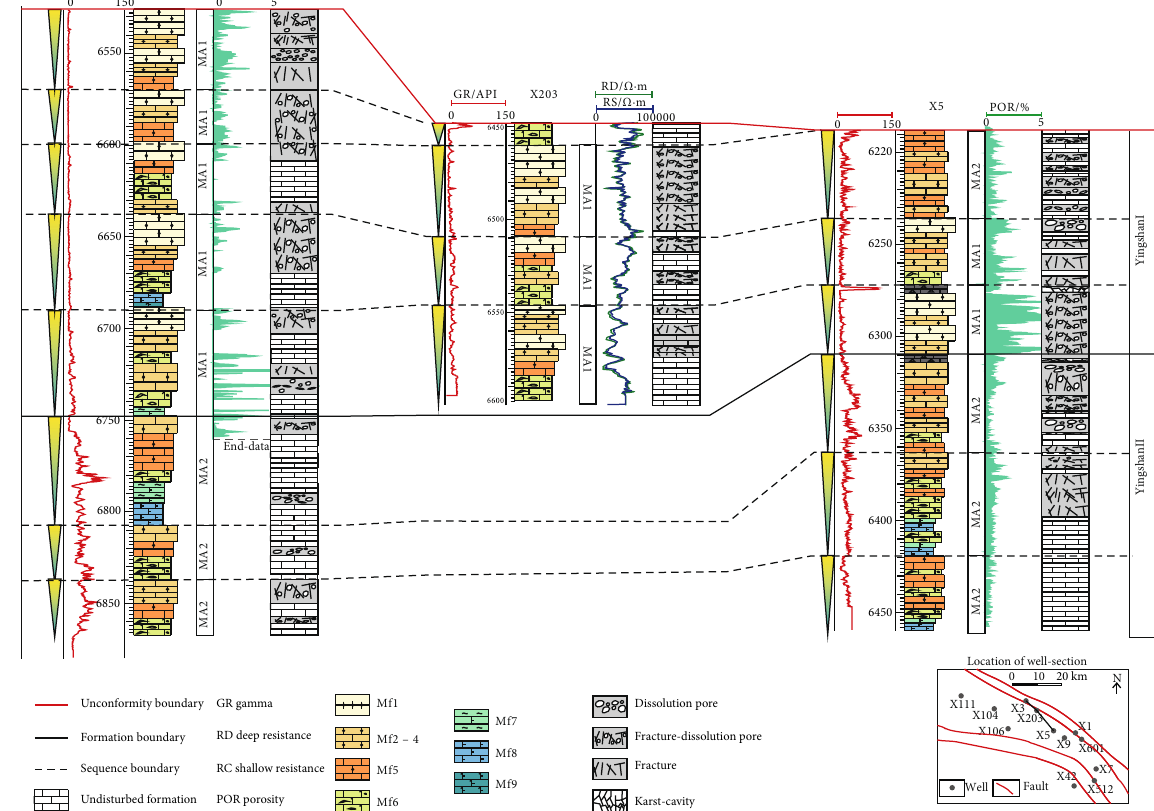
Figure 6: Microfacies association and reservoir space correlation section in Tazhong